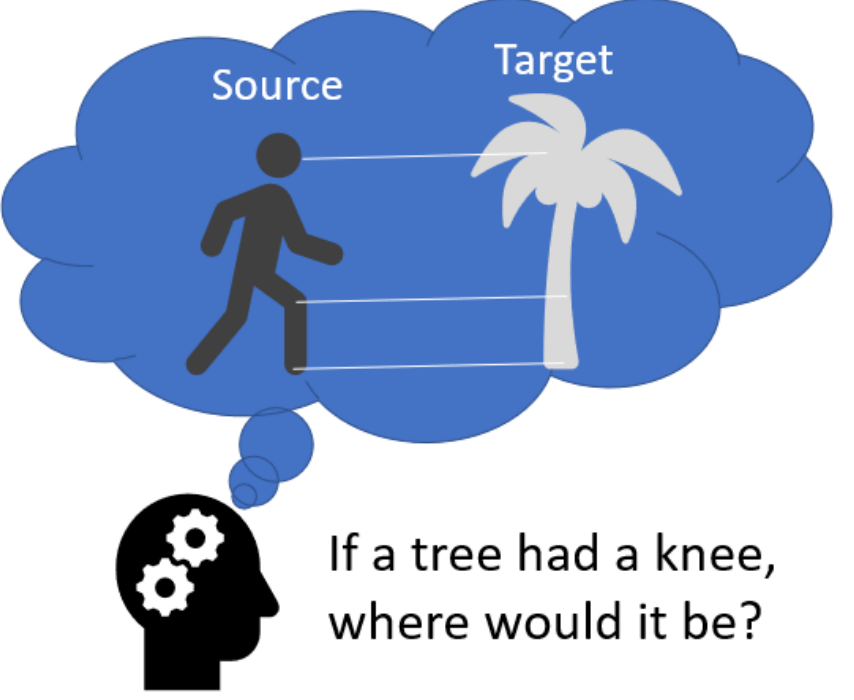
Figure 5. Visualization of how a human child can utilize analogical inference between two seem- ingly unrelated domains. unrelated